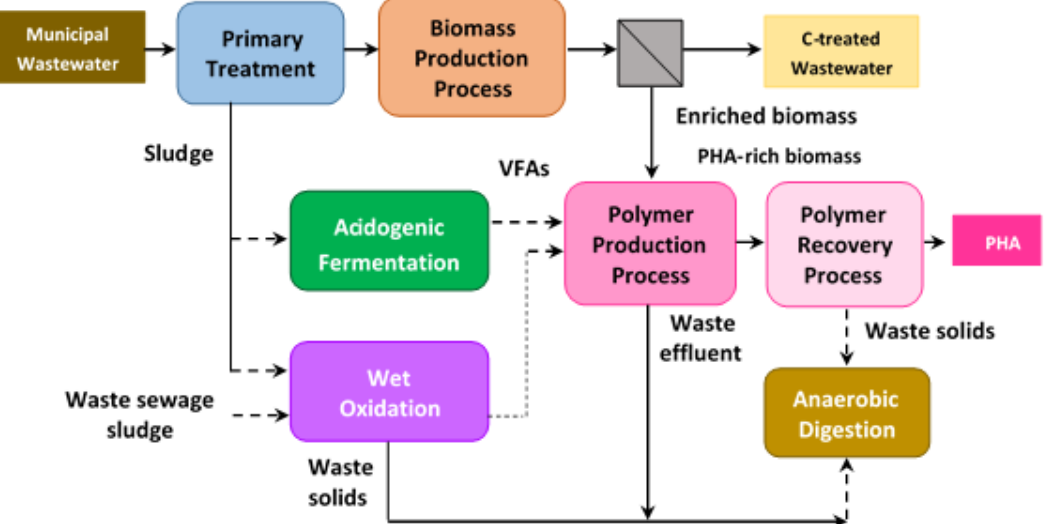
Figure 3. Schematic process flow diagram of municipal wastewater and sludge treatment together with the production of polyhydroxyalkanoates (PHA) (adapted from [168]) .